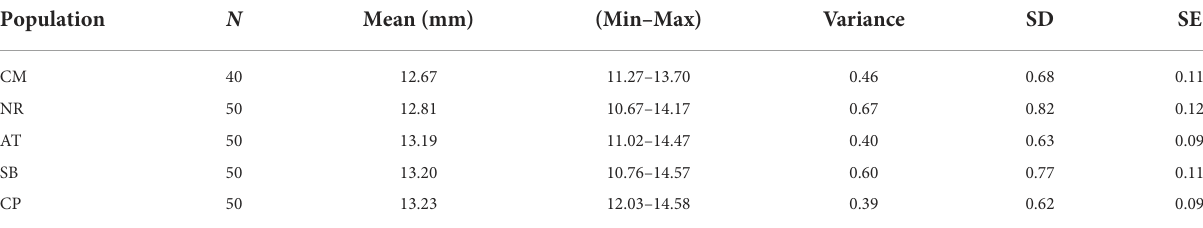
TABLE 2 Mean wing centroid size of Tabanus rubidus populations.